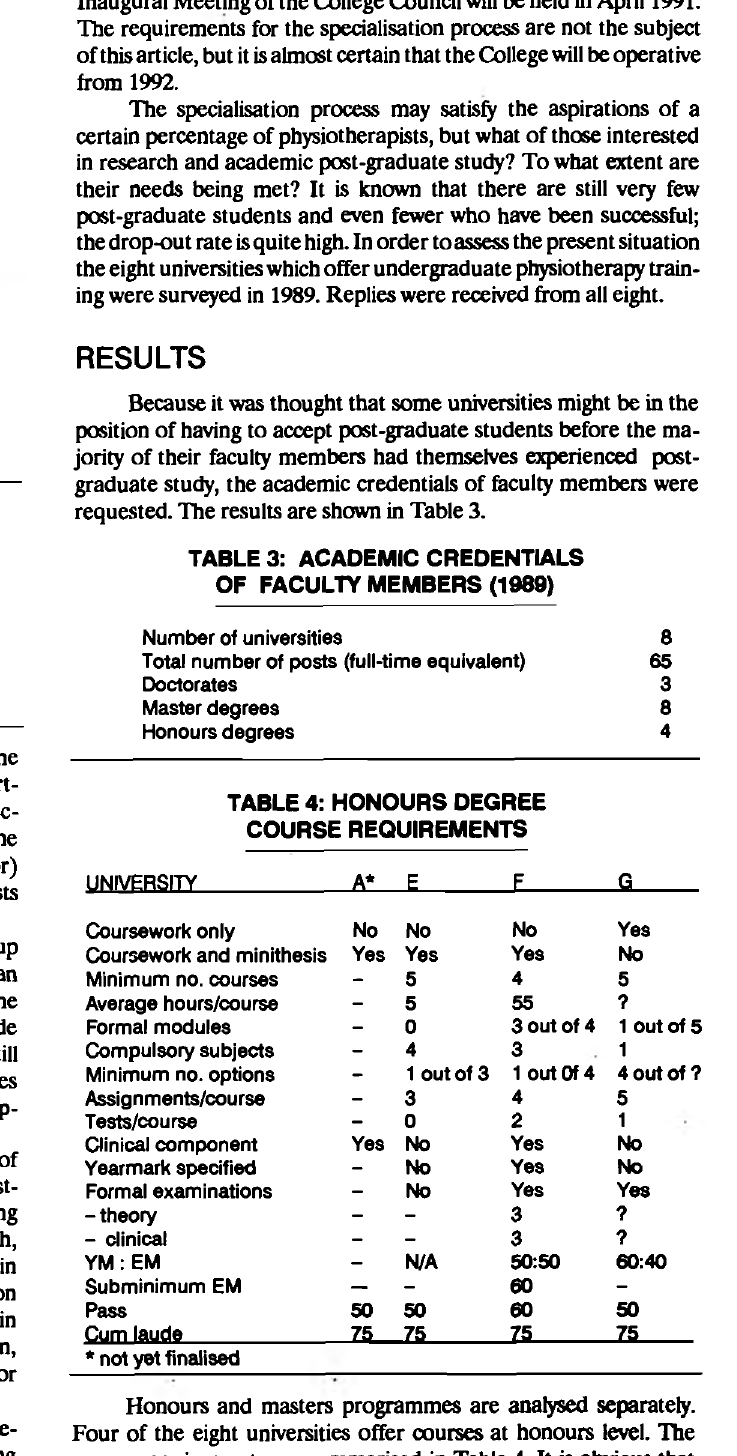
TABLE 1: CHARACTERISTICS OF